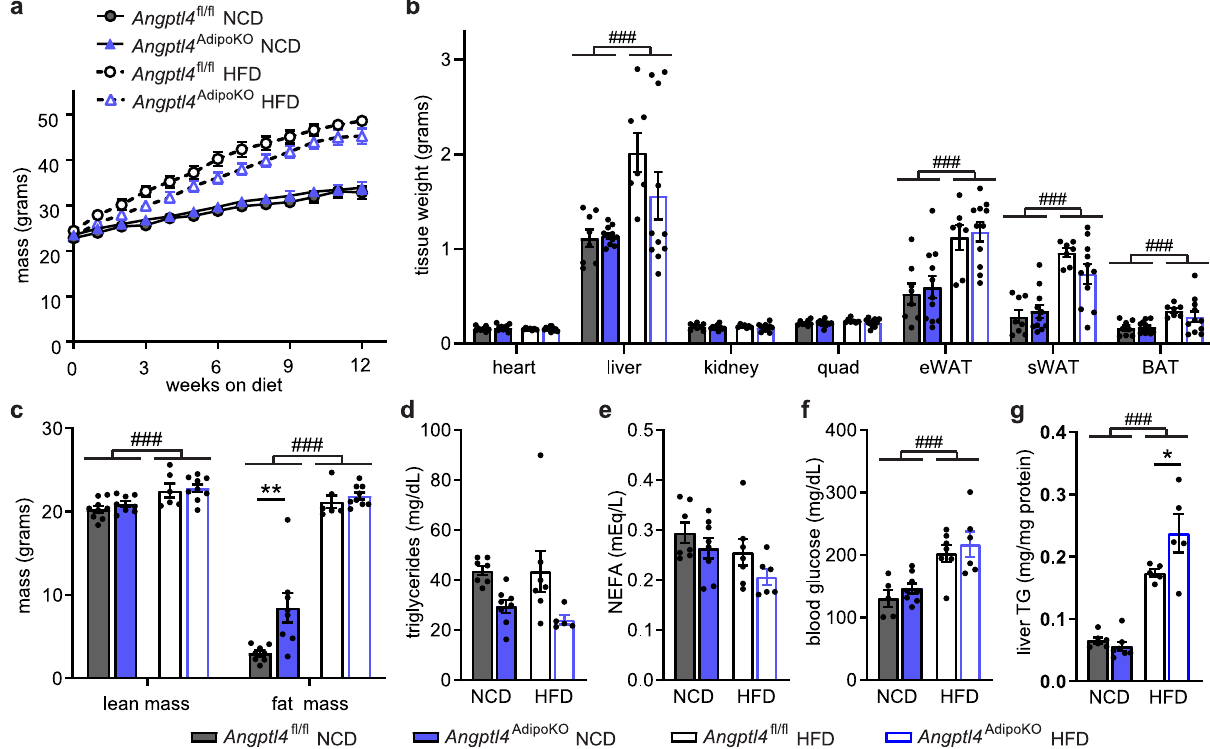
Figure 2. Body weights, fat mass, and metabolic phenotypes of Angptl4 fl/fl and Angptl4 AdipoKO mice. ( a ) Weekly body weights of male Angptl4 fl/fl and Angptl4 AdipoKO mice fed either a normal chow diet (NCD) or a high fat diet (HFD; 60% by kCal) for 12 weeks starting at 8 weeks of age (mean ± SEM; n = 12–19/group). ( b ) Tissues weights of heart, liver, kidney, quadriceps muscle (quad), epididymal white adipose (eWAT), subcutaneous white adipose tissue (sWAT), and brown adipose tissue (BAT) in male Angptl4 fl/fl and Angptl4 AdipoKO mice after 12 weeks on diet (mean ± SEM; n = 7–11group). ( c ) Lean muscle and fat mass of male Angptl4 fl/fl and Angptl4 AdipoKO mice as measured by NMR after 12 weeks on diet (mean ± SEM; n = 6–9/group). Plasma triglycerides ( d ), plasma non-esterified fatty acids ( e ), blood glucose ( f ), and liver triglycerides ( g ) of fasted (6 h) male Angptl4 fl/fl and Angptl4 AdipoKO mice at the end of 12 weeks on diet (mean ± SEM; n = 5–8/group). ###p < 0.001 for dietary differences by two-way ANOVA. *p < 0.05, **p < 0.01 for individual genotype-specific differences by multiple comparison after two-way ANOVA (Tukey